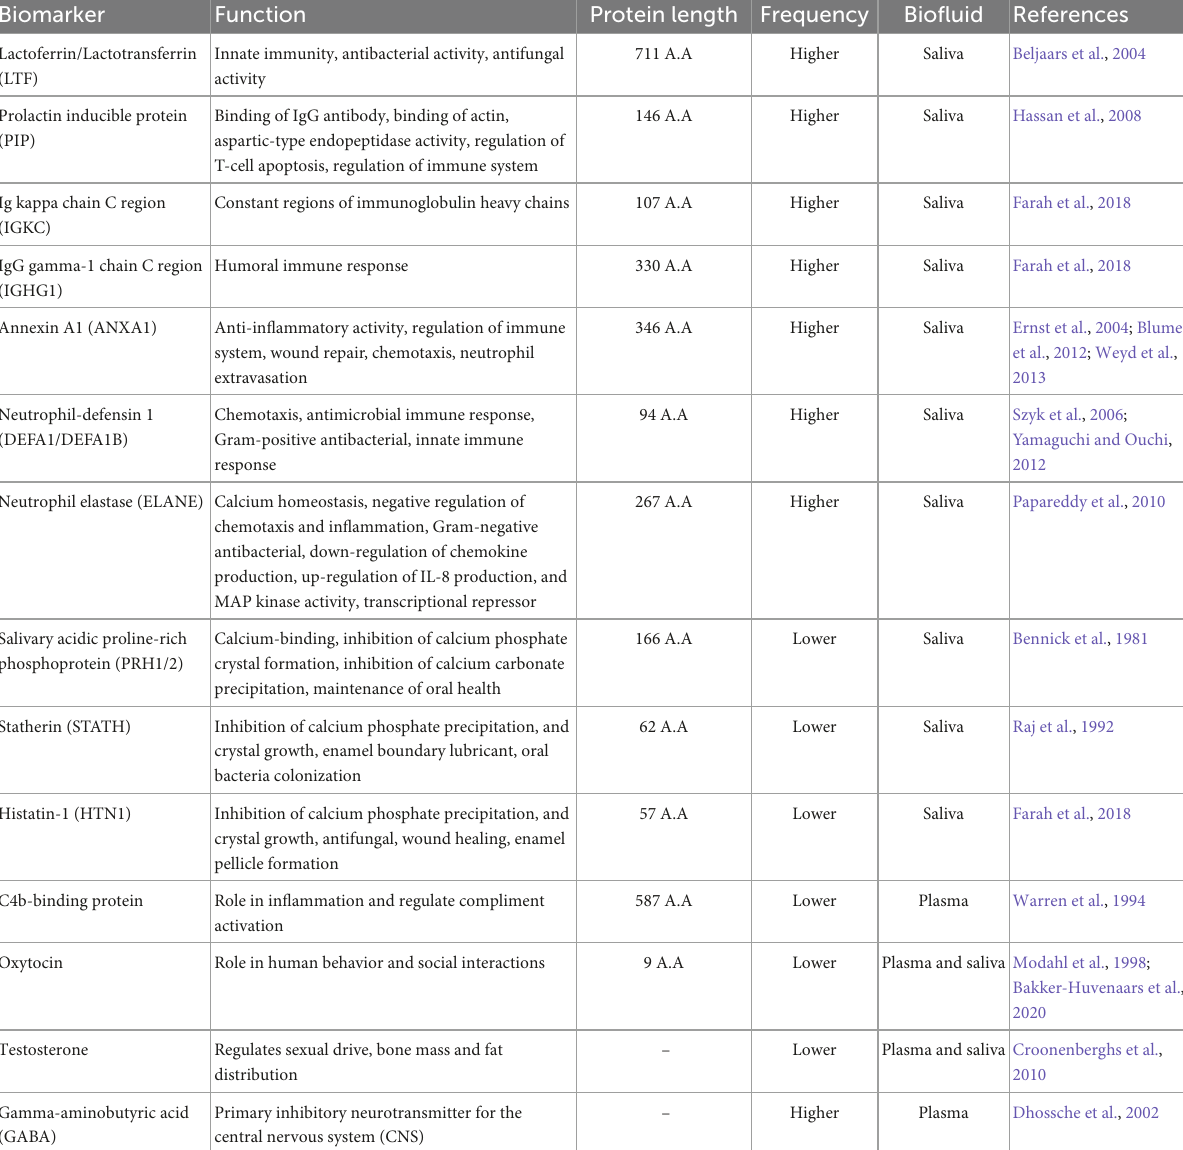
TABLE 1 Summarizes a comparative picture of biomarkers within the saliva fluid and blood plasma of Autism spectrum disorder (ASD) patients, along with their biological